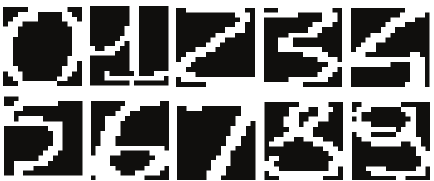
Figure 17: Data sample from the Semeion Handwritten Digit Data Set.